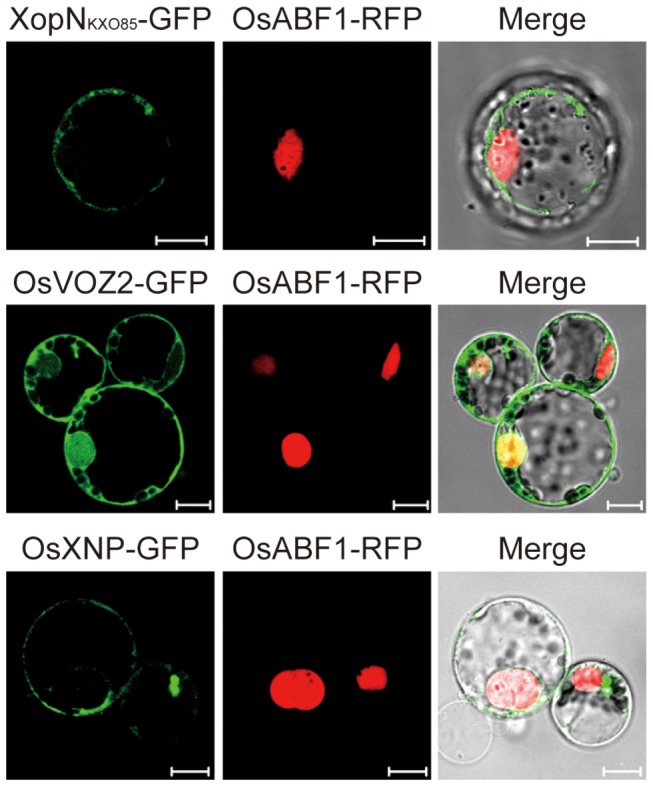
Localization of XopNKXO85, OsVOZ2, and OsXNP in plant cells.Subcellular localization of the XopNKXO85-GFP, OsVOZ2-GFP, and OsXNP-GFP fusion proteins in maize mesophyll cells. OsABF1-RFP was used as a nuclear marker. GFP (green) fluorescence was merged with RFP (red) fluorescence. Bars = 10 µm.